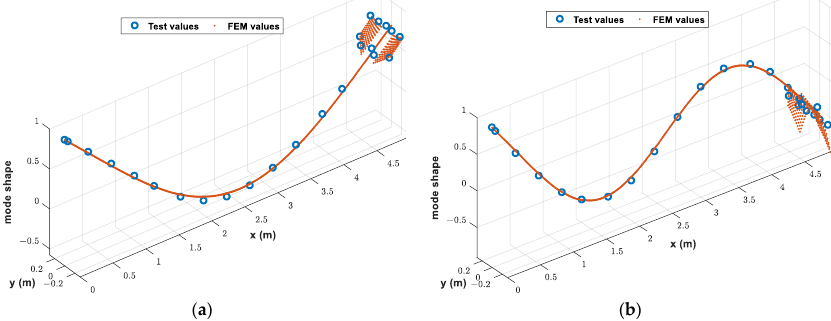
Figure 16. Mode shapes of test and FEM. ( a ) First bending mode. ( b ) Second bending mode.